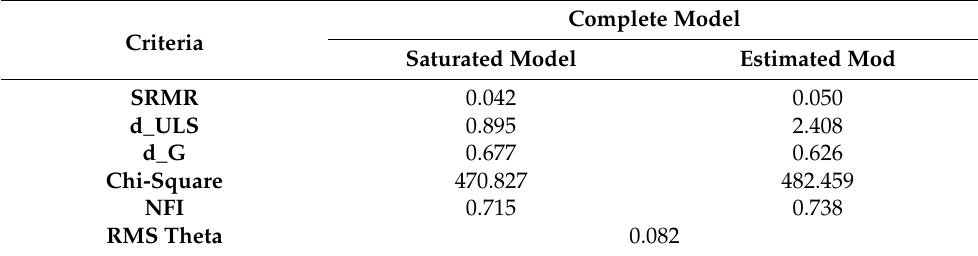
Table 7. Model fit